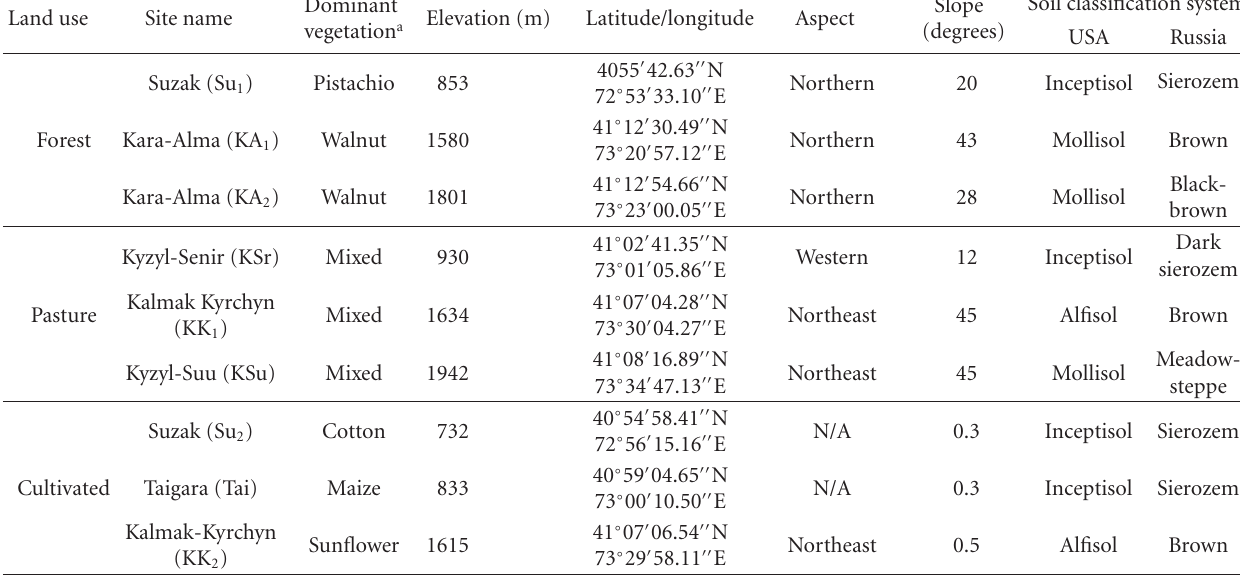
Table 1: General geographic description and soil classification from each land use site within the Kukart watershed, Kyrgyzstan. Land